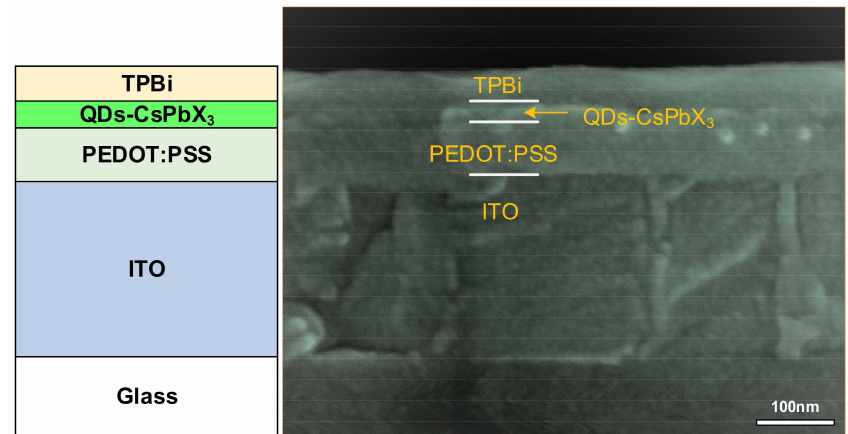
Figure 3. Device architecture and cross-sectional scanning electron microscope (SEM) image of the QDs-CsPbX 3 LED